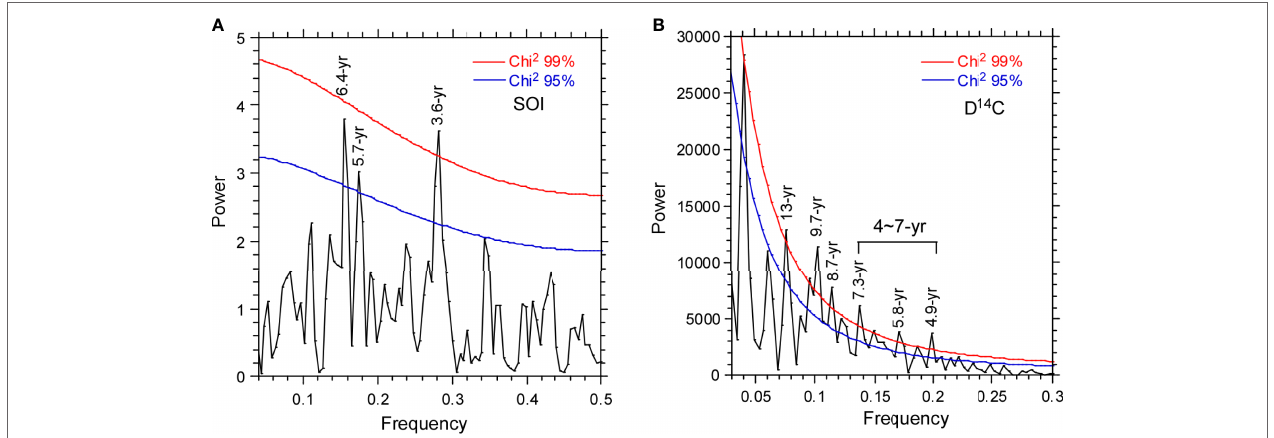
FIGURE 8 | Spectrum analysis for the SOI (data source: https://crudata.uea.ac.uk/cru/data/soi/) (A) and the D14CT OC (B) . The blue curve and red curve indicate confidence level and 95% and 99%, respectively. The numbers marked in the plots denote the possible cycles above 95% confidence